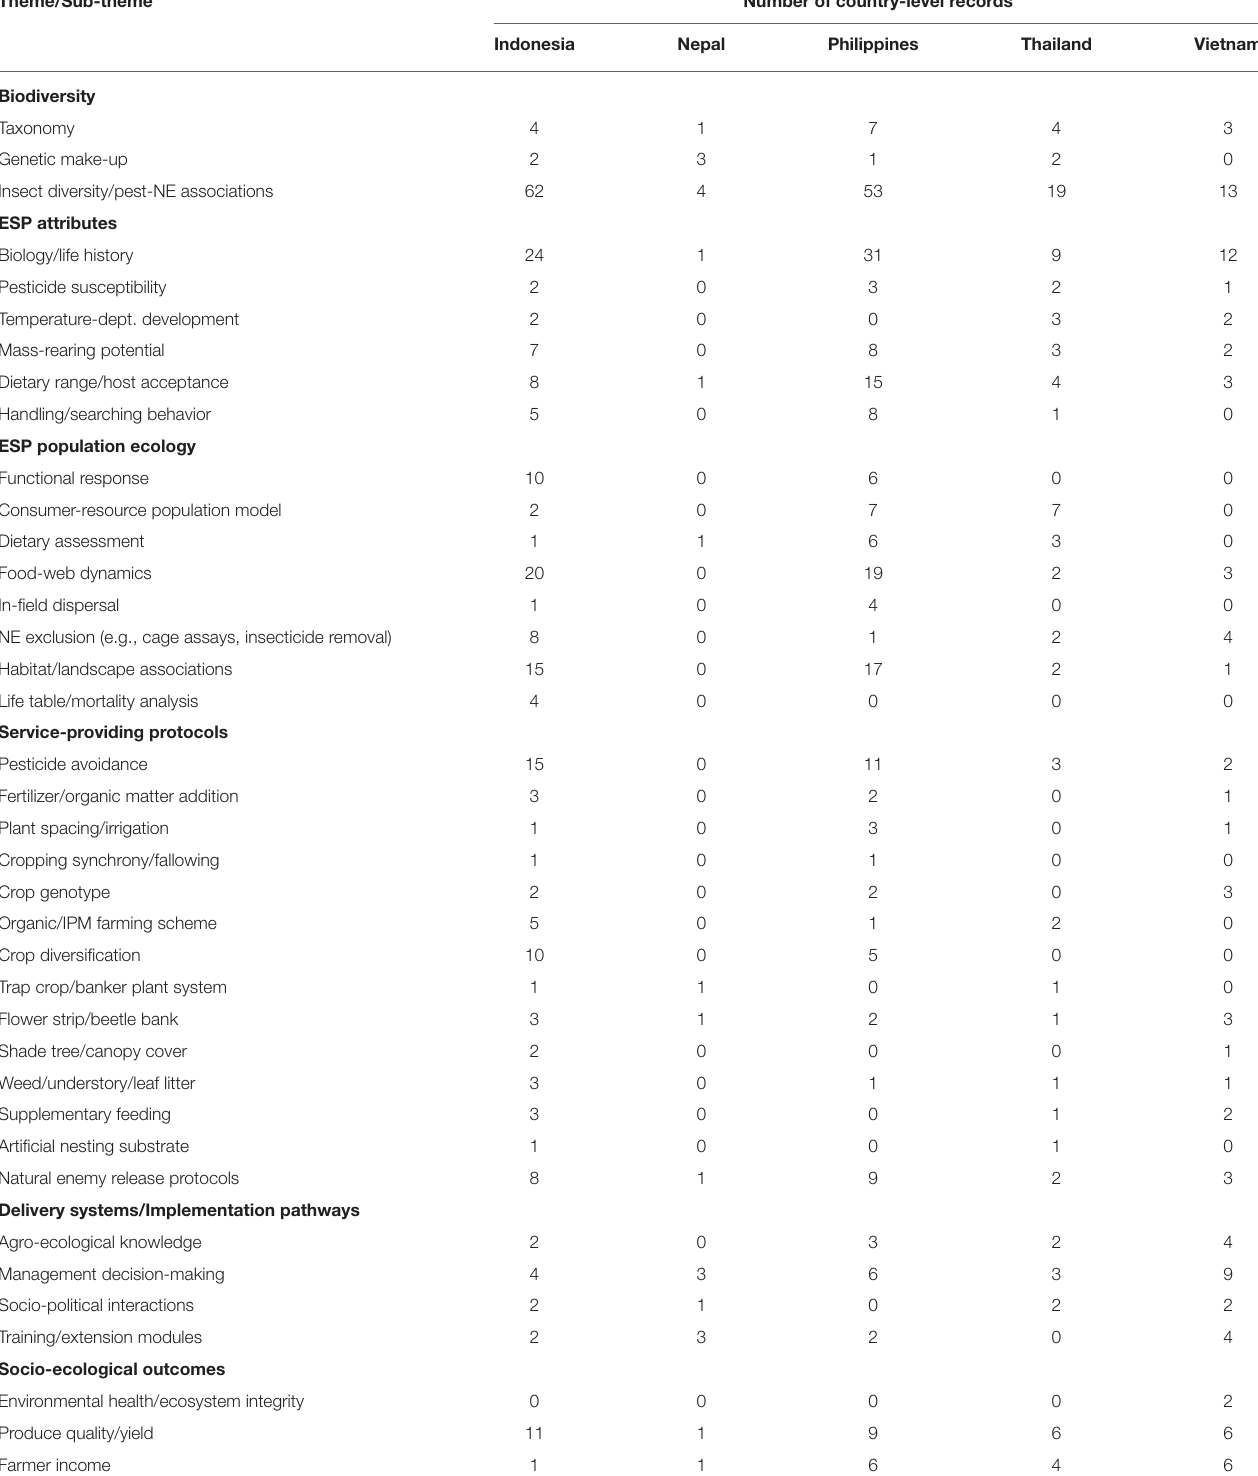
TABLE 1 | Comparative extent of scientific attention to different themes along a six-step, outcome-oriented impact pathway.